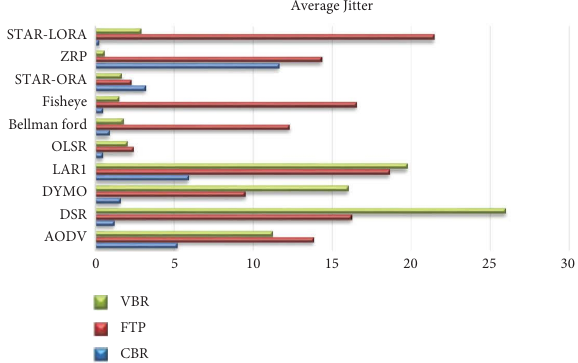
Figure 21: Average jitter of all routing protocols for 120